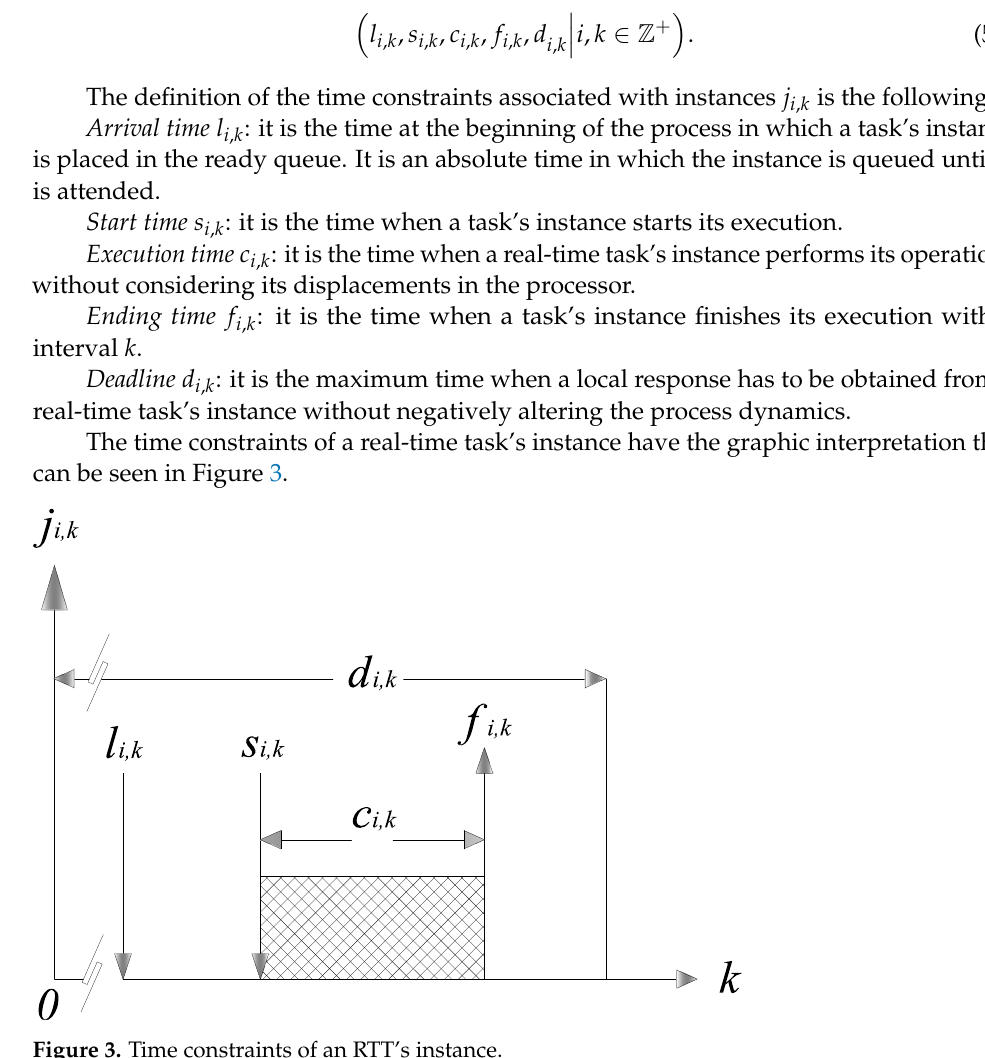
Figure 3. Time constraints of an RTT’s